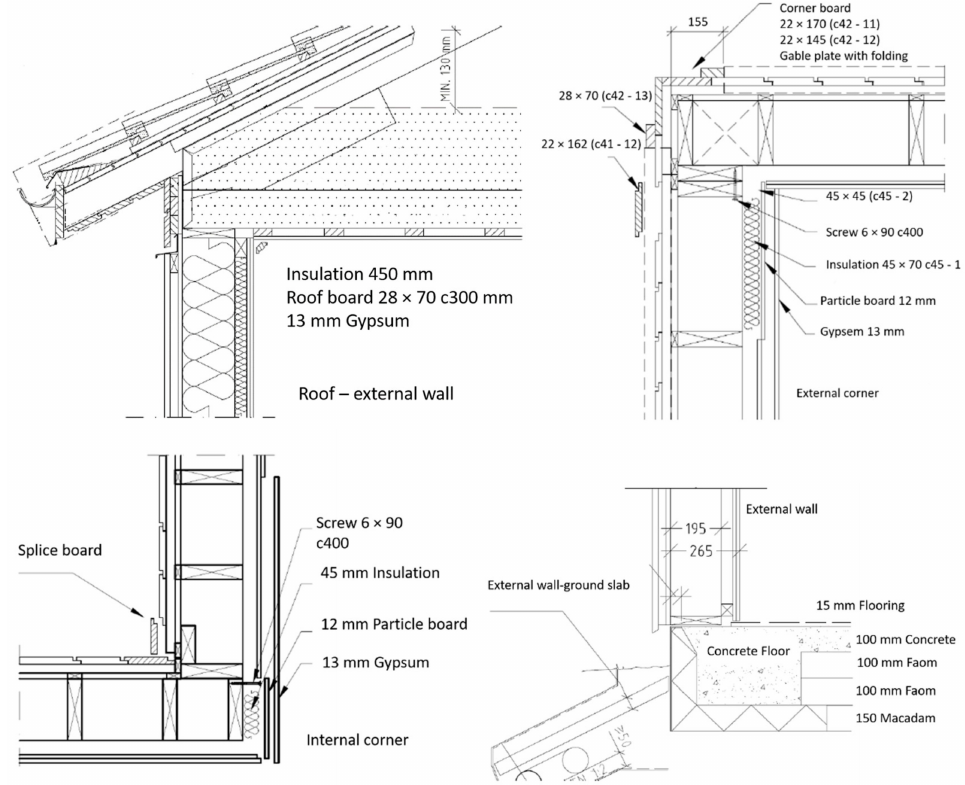
Figure 2. Thermal bridge layout for the connection between the external walls, roof, and floor in the reference